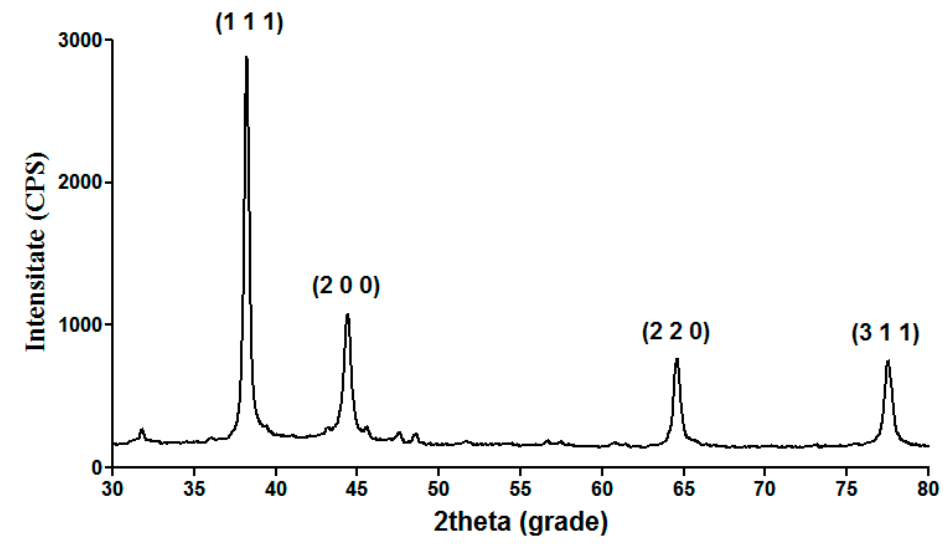
Figure 1. XRD pattern of NanoAg-WDs.